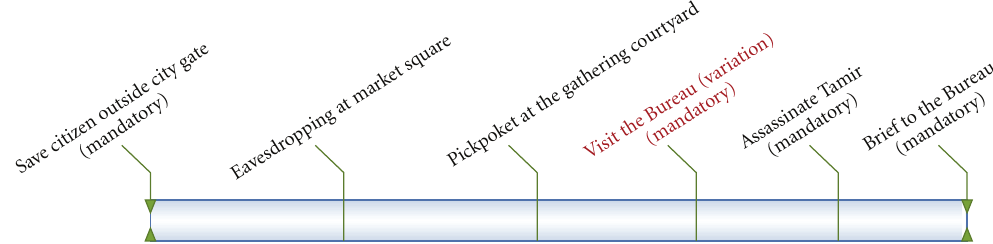
Figure 5: Damascus operational timeline: Sequence